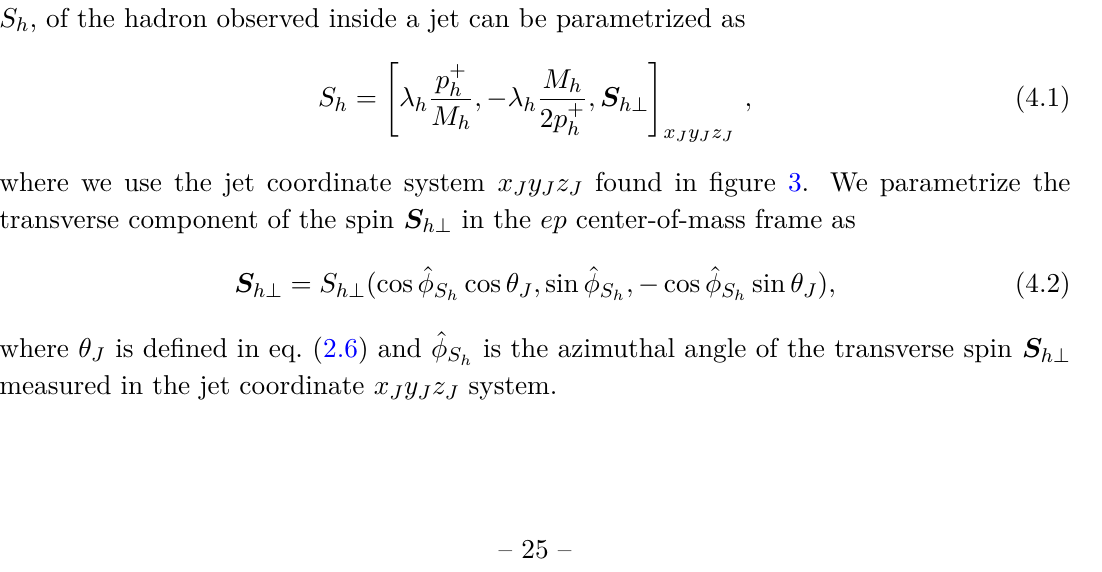
Figure 8 . Horizontal ( j ⊥ -dependent) and vertical ( q T -dependent) slices of A cos( φ q − and 7 for unpolarized π ± in jet production with electron in unpolarized ep collision as a function of transverse momentum j ⊥ (left panel, with q T = 1 . 0 , 0 . 5 GeV for π ± ) and jet imbalance q T (right panel, with j ⊥ = 1 . 0 , 0 . 5 GeV for π ± ), respectively. Here we apply the EIC kinematics with √ s = 89 GeV, jet radius R = 0 . 6 , inelasticity y in range [0 . 1 , 0 . 9] , Q 2 > 10 GeV 2 , Bjorken- x in [0 . 15 , 0 . 20] and average momentum fraction h z h i = 0 . 3